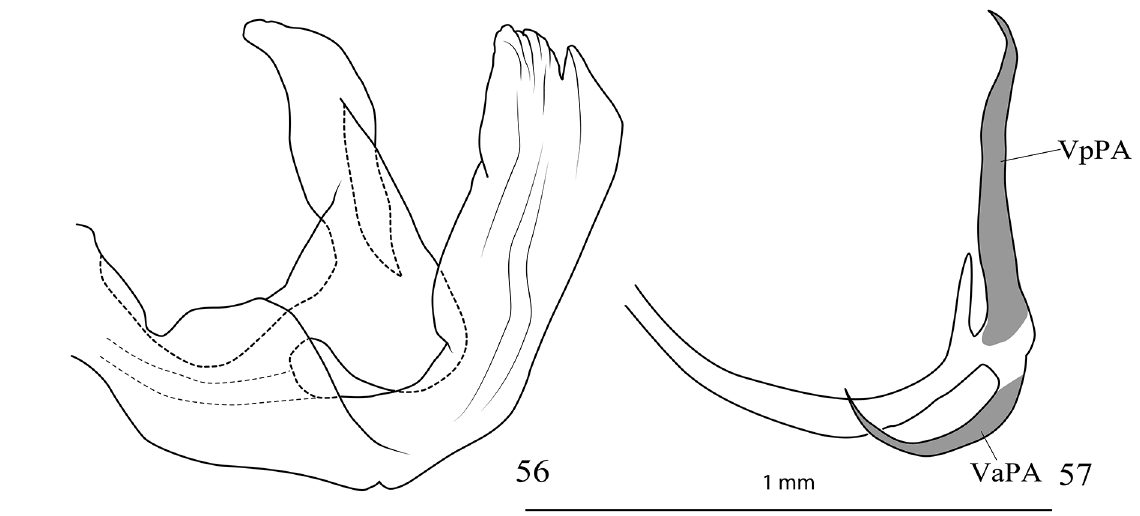
Figs 56–57. Serida parenthesisflexuosa Wang & Soulier-Perkins, sp. nov. 56 . Periandrium, lateral view. 57 . Aedeagus, lateral